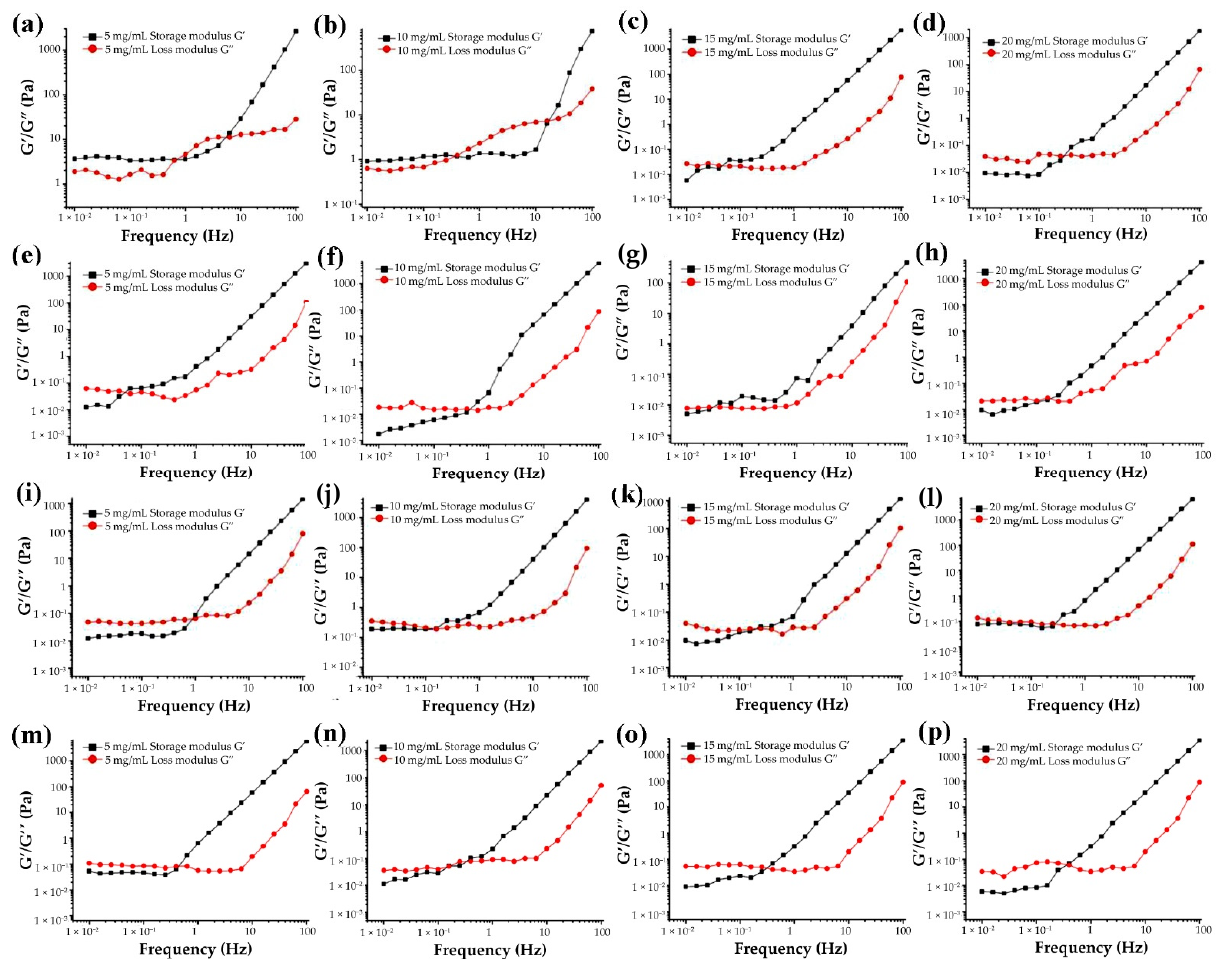
Figure 9. Frequency dependence of storage (G’) and loss (G”) modulus of G ‐ HBSS ( a – d ), G ‐ CHSS Figure ( e – h ), G ‐ DASS ( i – l ), and G ‐ CASS ( m – p ) at different concentrations.